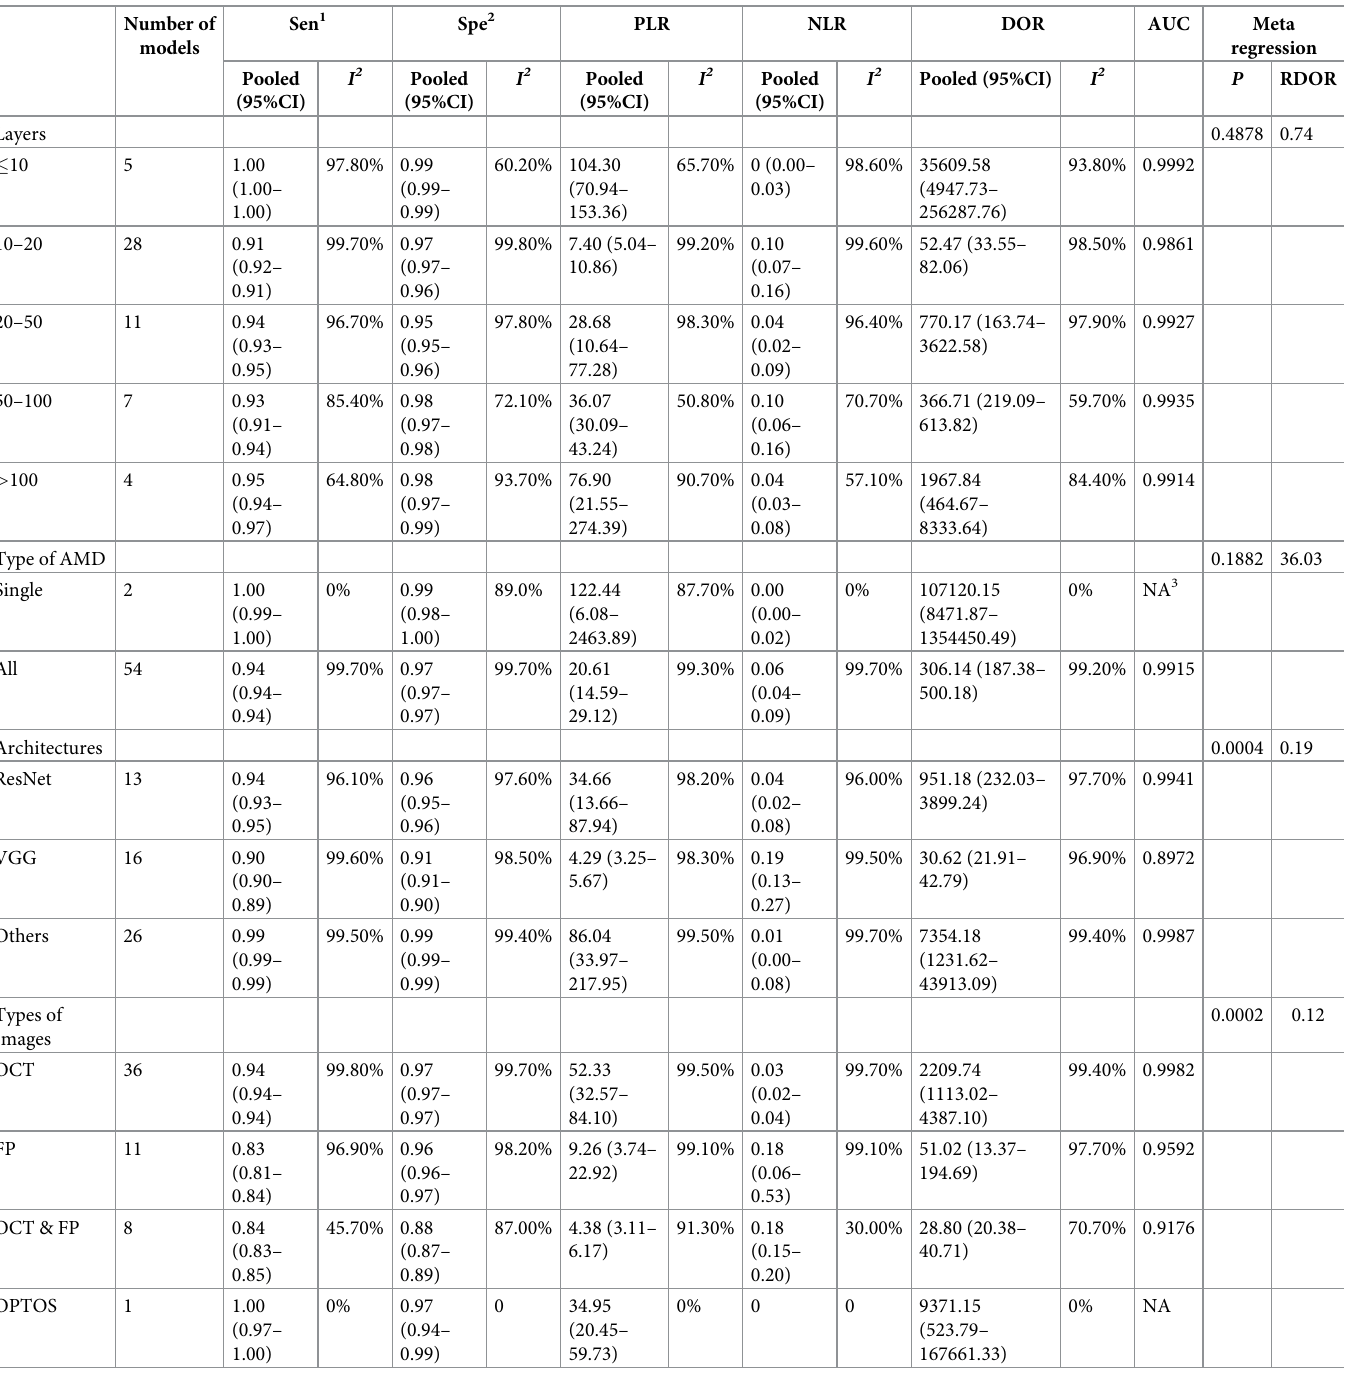
Table 3. Subgroup analyses and meta regression